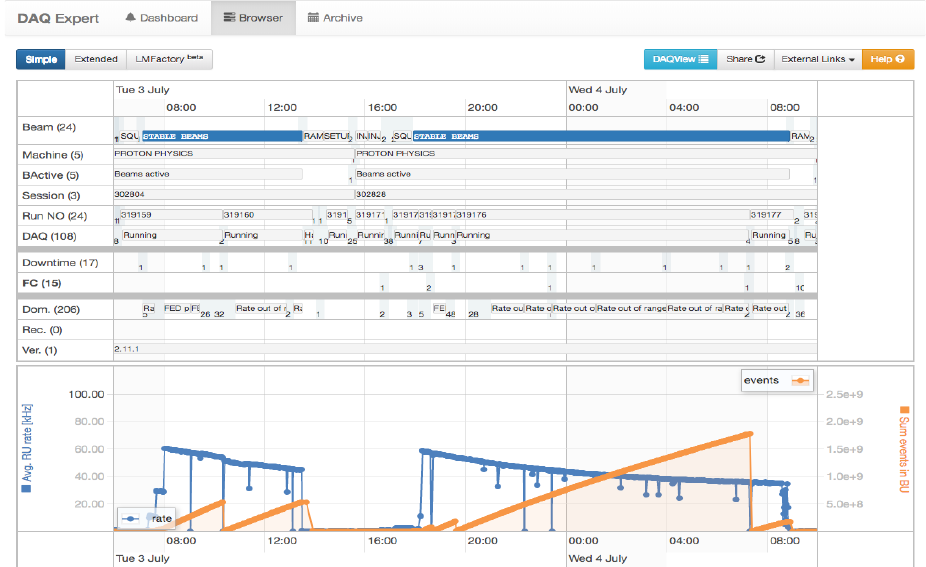
Fig. 2. The web-based timeline browser. The top frame shows states of the LHC, and the DAQ system. The middle frame shows the conditions of the reasoning logic. The bottom frame shows the history of the trigger rate and number of events collected in a run. The user may freely zoom from showing periods of months down to seconds. The information is downscaled to the appropriate resolution at the